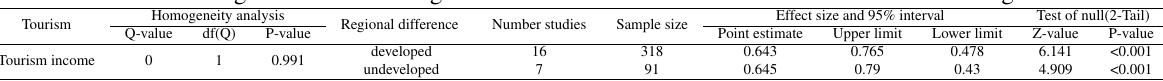
Table 4 The regulation effect of regional difference between tourism income and economic growth